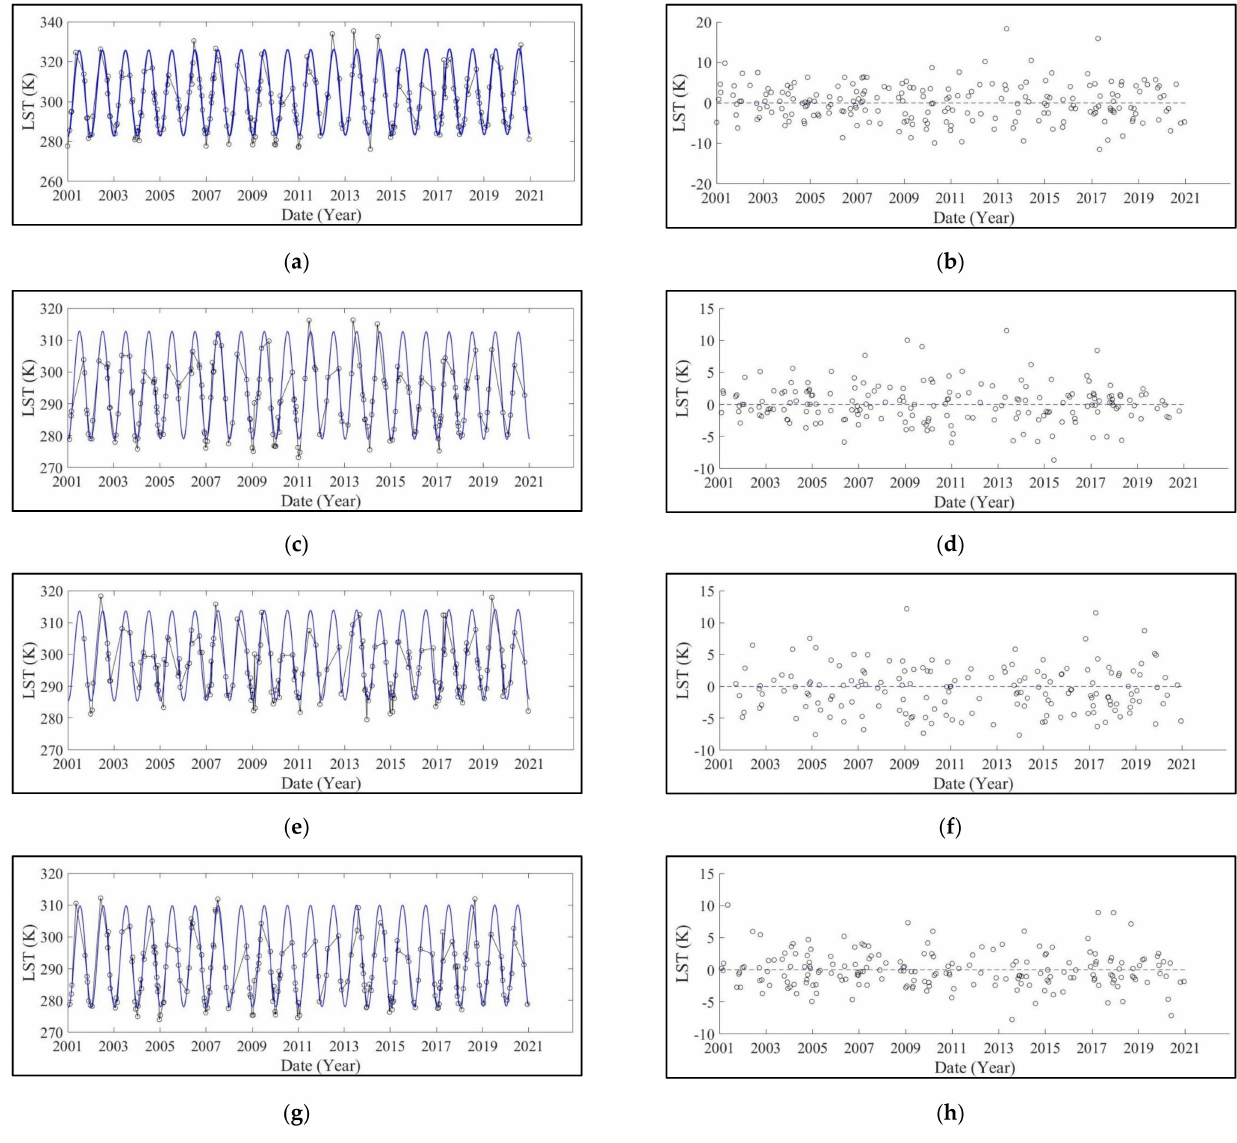
Figure 15. Examples of estimated LST data (after ignoring contaminated value), modeled LST and residuals: ( a ) estimated and simulated LST at Point_U where LULC type is urban and built-up land, ( b ) residuals at Point_U, ( c ) estimated and simulated LST at Point_A where LULC type is agricultural land, ( d ) residuals at Point_A, ( e ) estimated and simulated LST at Point_F where LULC type is forest land, ( f ) residuals at Point_F, ( g ) estimated and simulated LST at Point_W where LULC type is water bodies, ( h ) residuals at